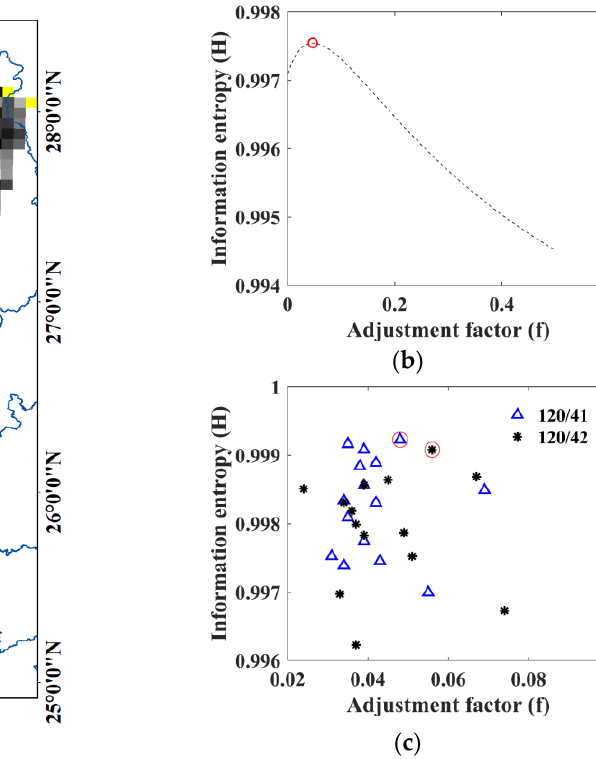
Figure 3. Blocks and adjustment factors: ( a ) Blocks (yellow pixels) in slope image with 6-km spatial resolution; ( b ) optimized adjustment factor for a block, marked in red circle; ( c ) best adjustment factors for two scenes of Landsat 8 OLI images, marked in red circles.